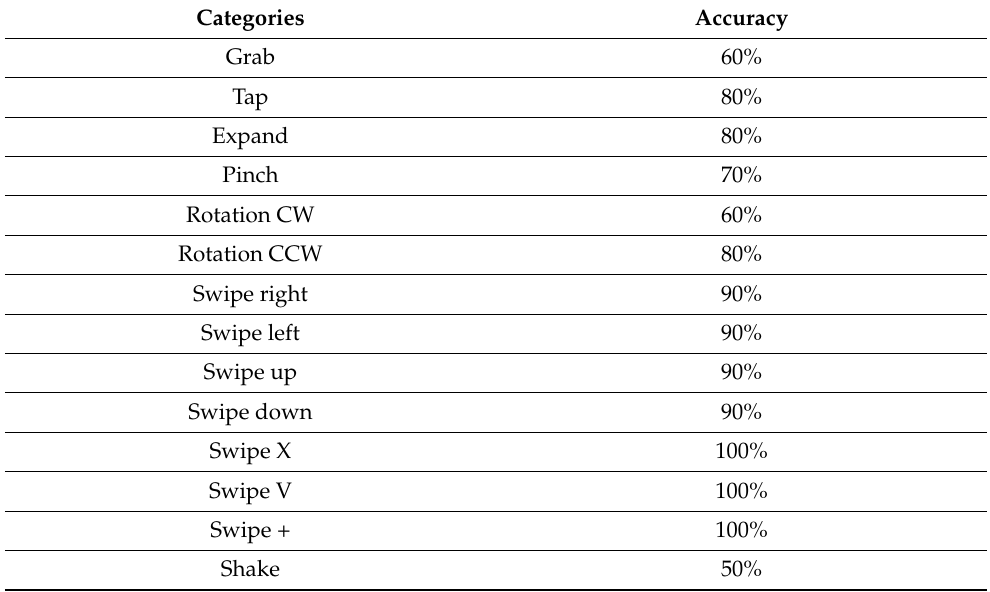
Table 3. Results of hand action recognition